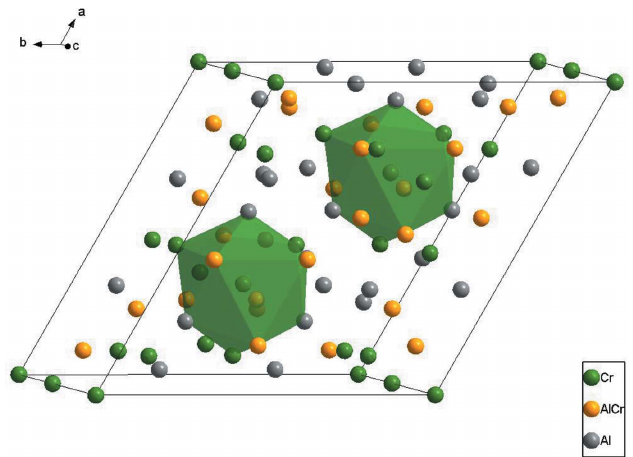
Figure 1 The crystal structure of Al 7.85 Cr 5.16 . The icosahedra centred on Cr4 are